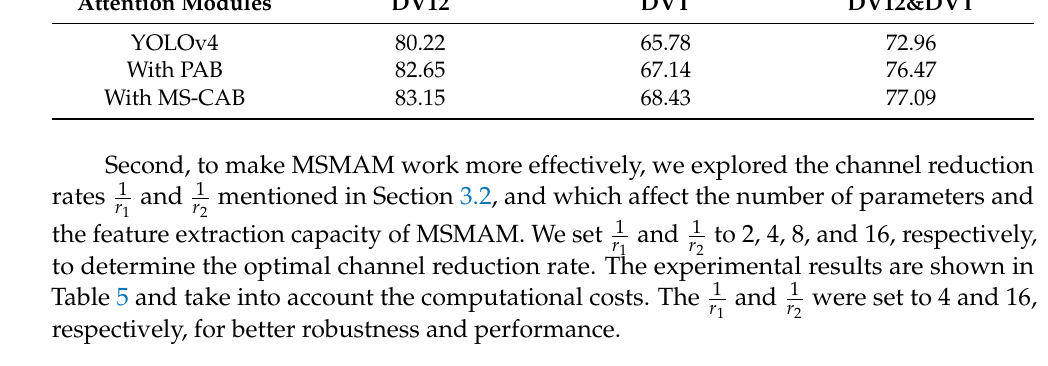
Table 5. Influence of attention channel size on detection results (AP; unit: %). r = 2, 4, 8, 16,